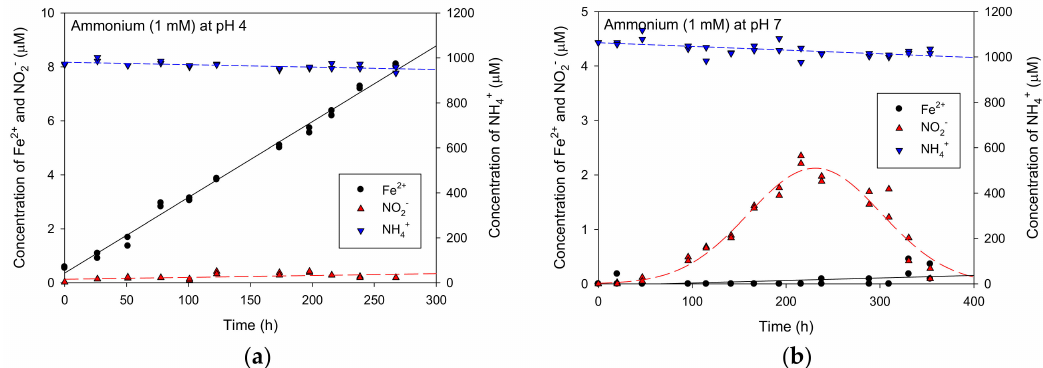
Figure 5. The Fe 2 + and NO 2 − production kinetics for NH 4 + used as a reduced material at ( a ) pH 4 and ( b ) pH 7.